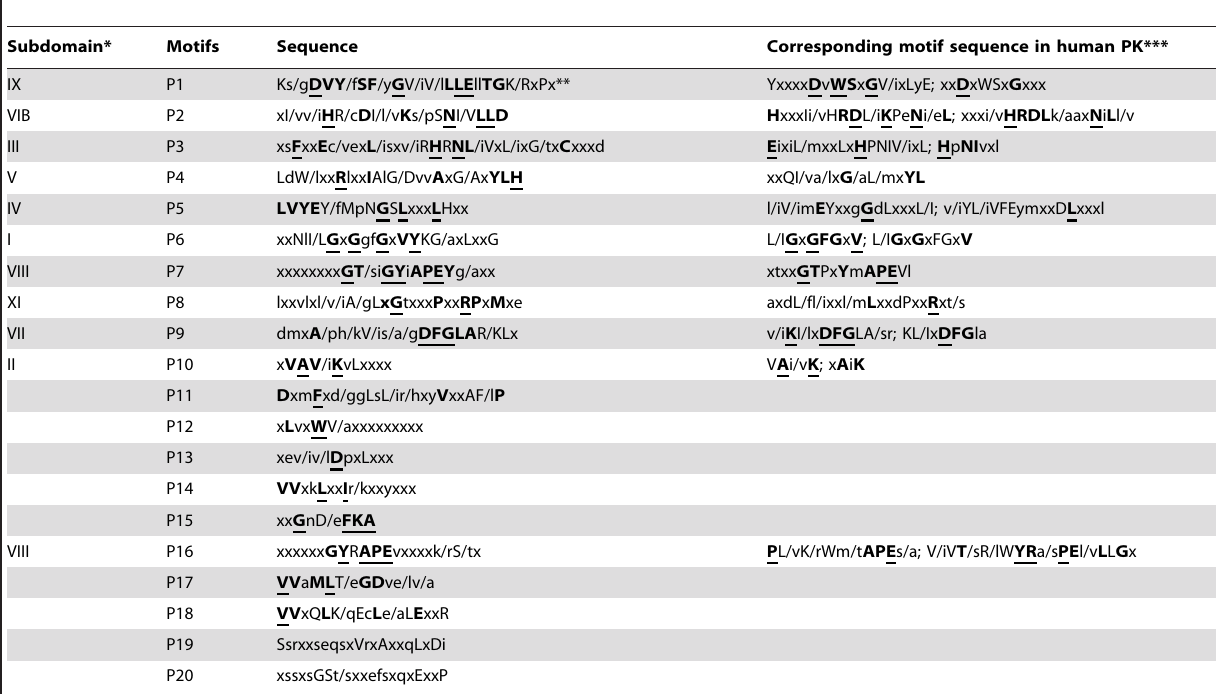
Table 4. Major motifs of protein kinase domain in predicted rice